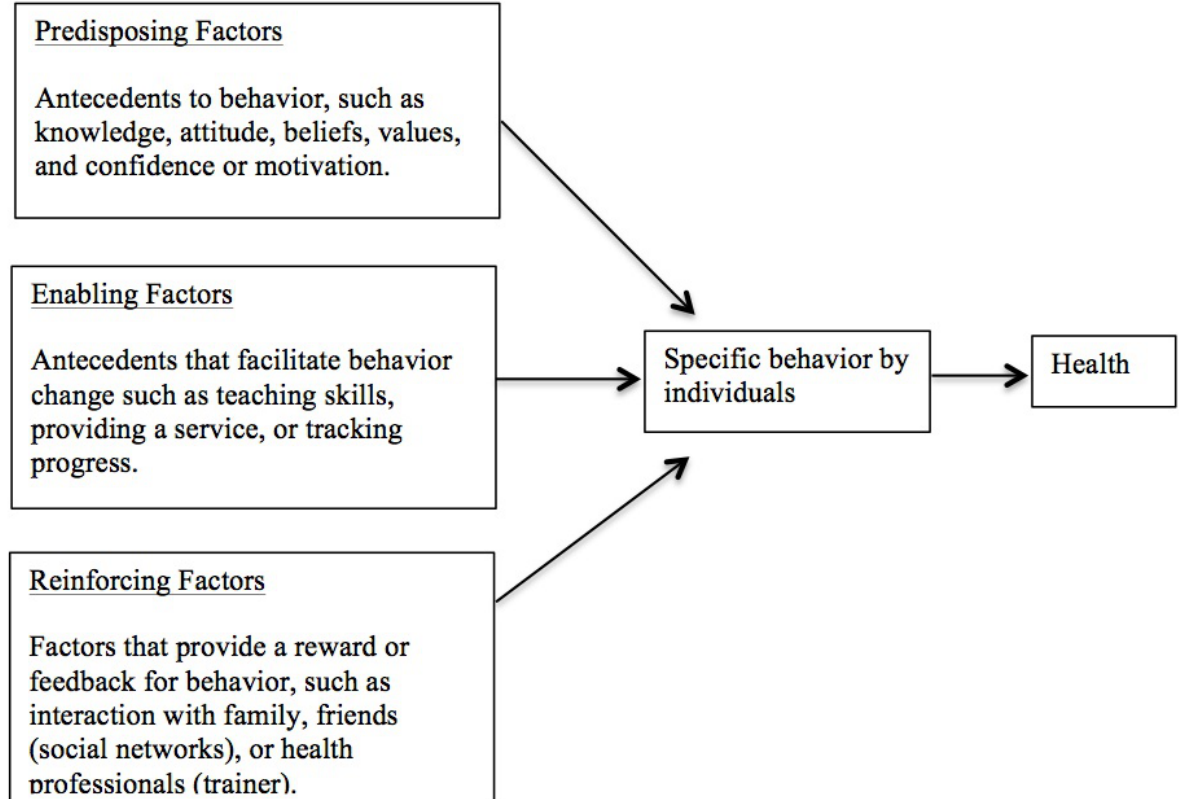
Figure 1. Causal relationship of Precede-Proceed Model factors influencing behavior and health, adapted from the Precede-Proceed Model for